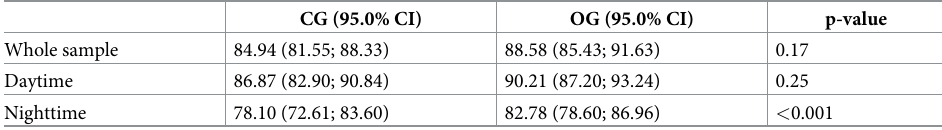
Table 3. The mixed linear model to analyze the effect of obesity on the glucose